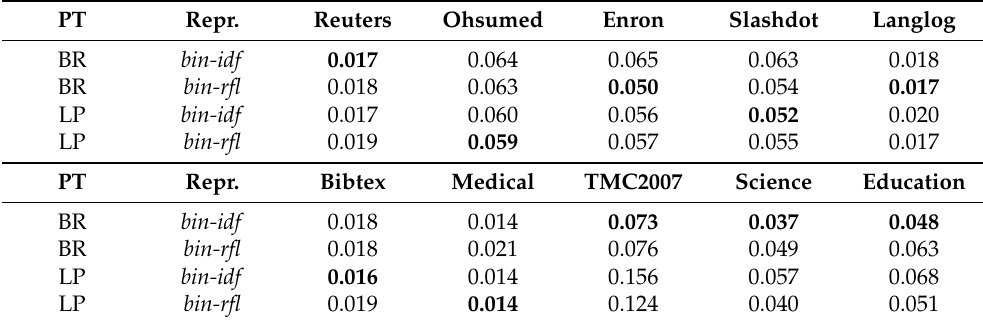
Table 8. Experimental results of different transformations of the problem (PT: BR and LP), and Representations with SVM in terms of Hamming Loss.